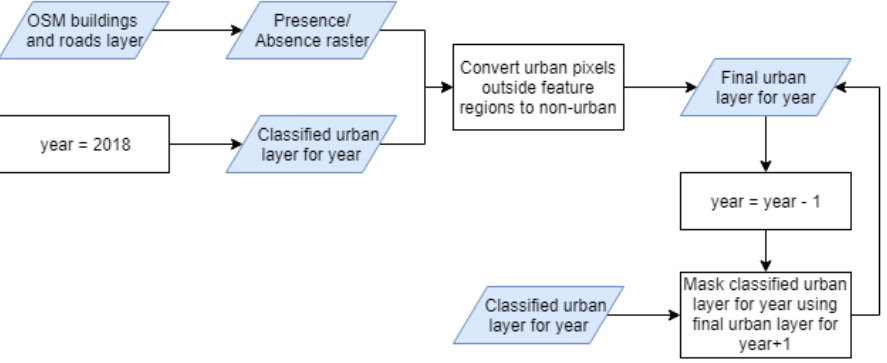
Figure 3. Backpropagation of updating built-up areas to preserve logical consistency of land-cover